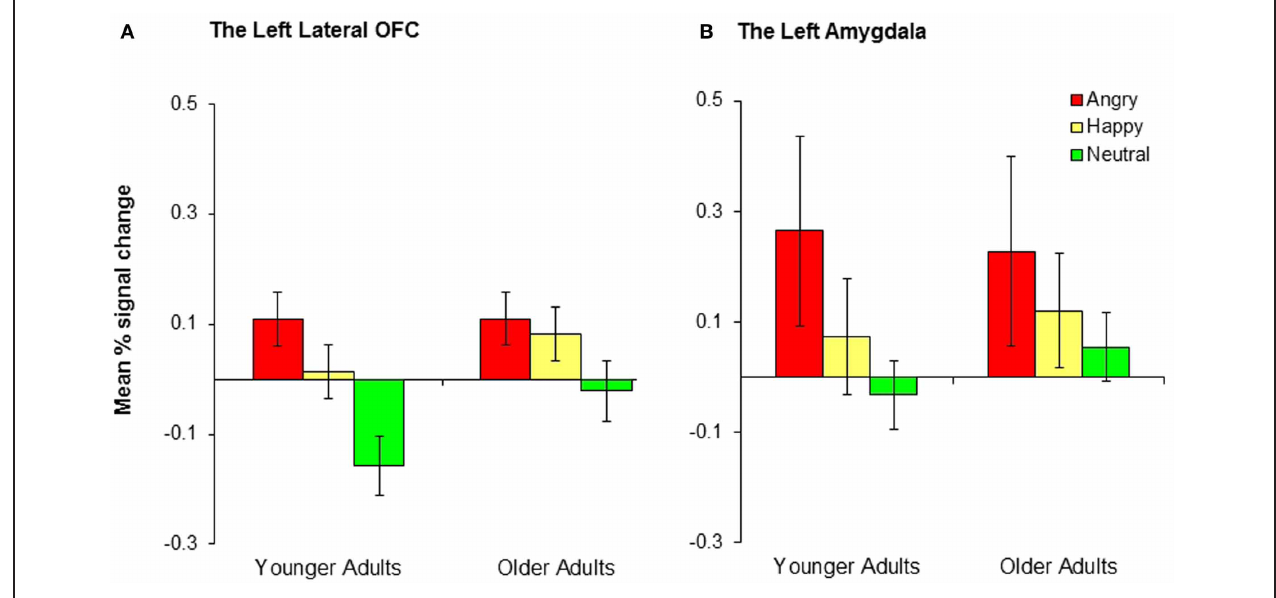
FIGURE 3 | Younger and older adults showed similar patterns of activity in (A) the left lateral OFC and (B) the left amygdala across conditions. Collapsed across groups, participants showed significantly greater activity in